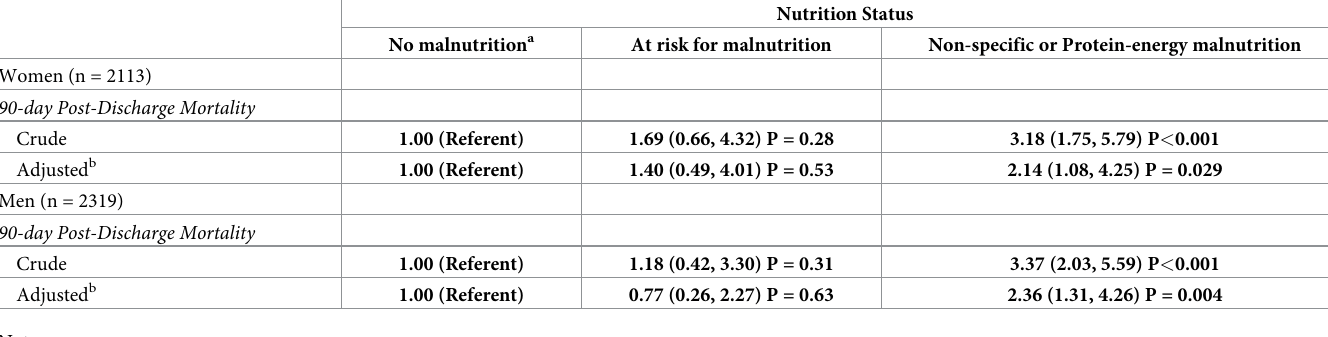
Table 4. Unadjusted and adjusted associations between nutrition status and 90-day post-discharge mortality relative to sex.